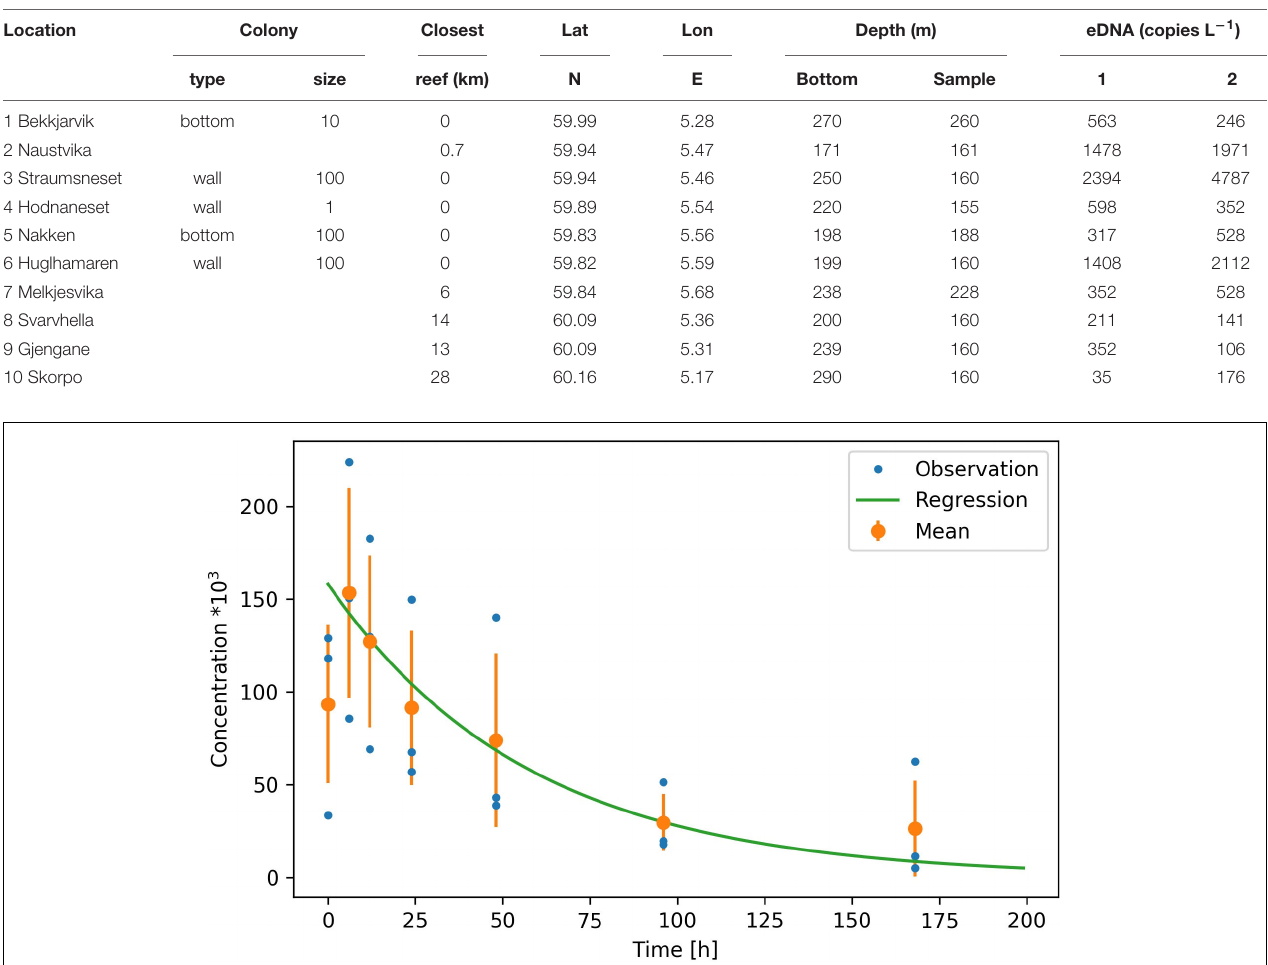
TABLE 2 | Properties of the sampling sites, and eDNA concentrations (eDNA copies l − 1 ) measured in two parallel Niskin bottles sampled at the 10 sites dispersed in the study region. Location